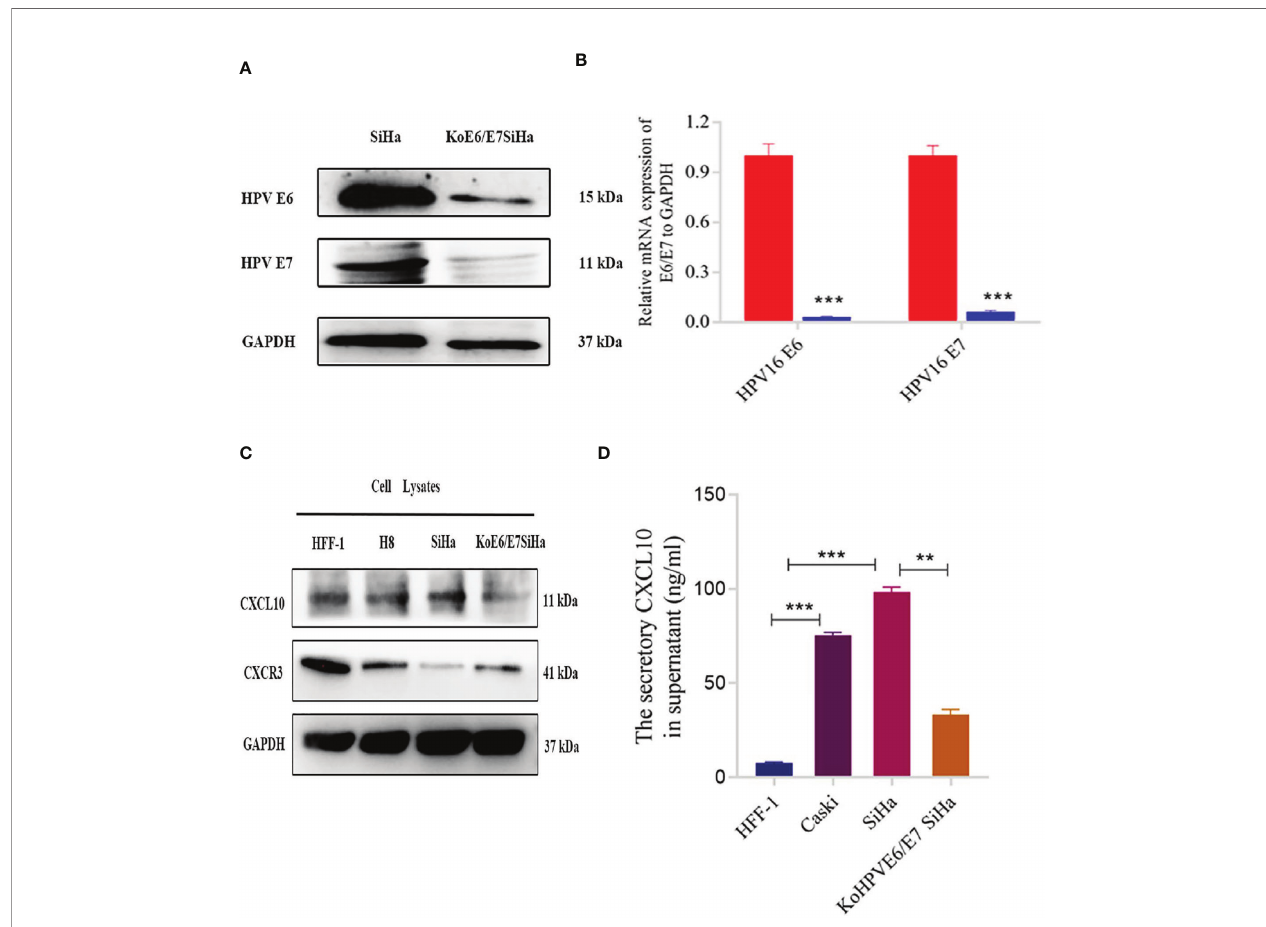
FIGURE 2 | Expression of CXCL10 in different cells revealed by western blotting and Elisa. (A, B) The results of western blotting and qPCR veri fi ed that the KoE6/ E7SiHa cell line was established successfully by CRISPR/Cas9 gene editing; (C) The expression of CXCL10 was tested through western blotting in different cell lines including HFF-1, H8, SiHa and KoE6/E7 SiHa; (D) The result of Elisa displayed increased secretion of CXCL10 in cervical cancer cells (SiHa and Caski), while was reverse in koE6/E7SiHa cell. *P < 0.05, **P < 0.01, ***P<0.001 and ****P < 0.0001, as determined by Student ’ s